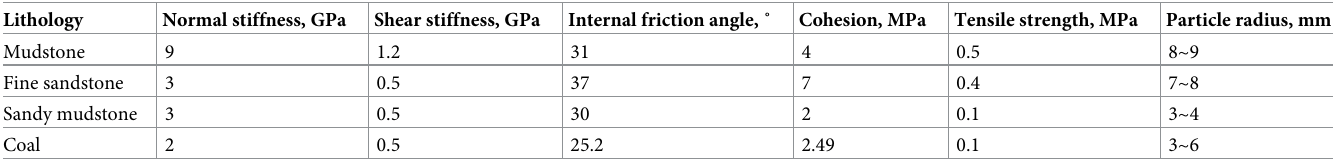
Table 1. Rock mass properties used in numerical modelling. Lithology Normal stiffness,